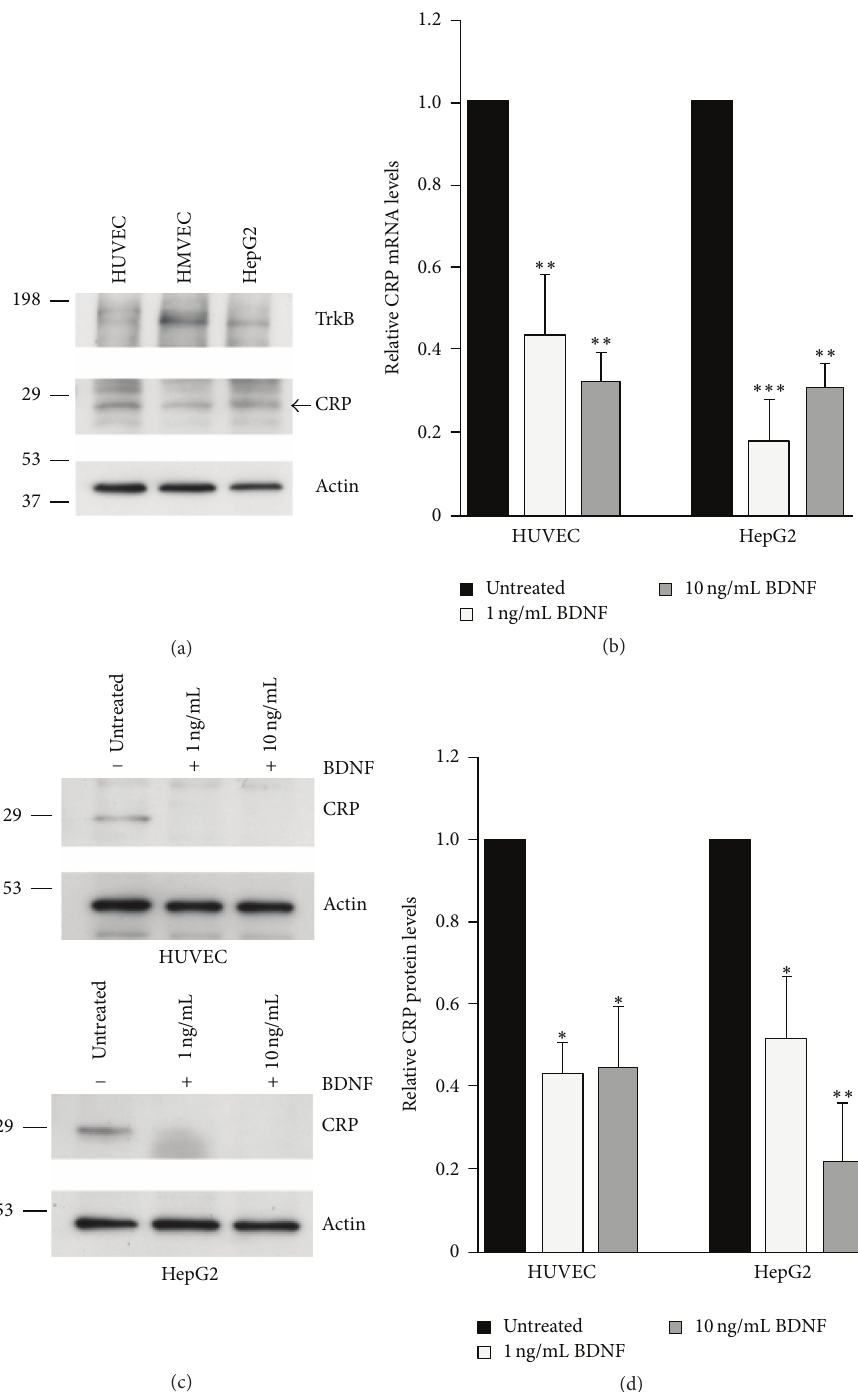
Figure 3: BDNF reduces CRP levels in cells. (a) HUVECs, HMVEC-C, or HepG2 cells were lysed, separated by SDS-PAGE and probed with anti-TrkB, anti-CRP, and anti-actin antibodies as a loading control. (b) HUVECs were untreated or treated with the indicated concentrations of BDNF for 18 hrs and CRP mRNA levels were assessed by RT-qPCR and normalized to GAPDH. (c) Cells treated as in (b) were lysed and probed with anti-CRP and anti-actin antibodies as a protein loading control. (d) CRP protein levels were quantified from immunoblots and normalized to actin. The histograms represent the normalized mean + SEM from 3 independent experiments. ∗ 𝑝 < 0.05 , ∗∗ 𝑝 < 0.01 , and ∗∗∗ 𝑝 < 0.001 using one-way ANOVA and Tukey’s post hoc